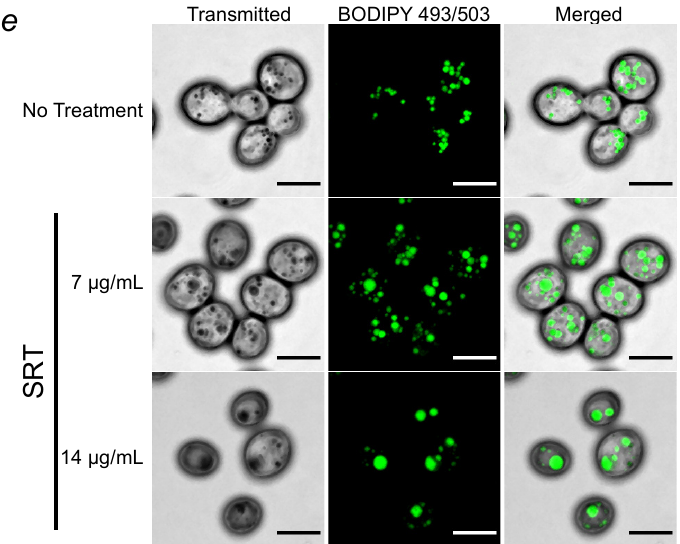
Figure 3. SRT treatment induces SLDs in C. albicans and S. cerevisiae . ( A ) Treatment with SRT induces the formation of enlarged LDs and reduces hyphal growth in C. albicans . SC5314 cells were grown for 12 h in YPD at 30 °C with 150 RPM shaking, then resuspended to a density of 5.0 × 10 6 cells/mL in fresh RPMI-1640 containing the drug. Treated cultures were incubated for 12 h at 37 °C with 150 RPM shaking. Cells were then harvested by centrifugation, fixed with 4% paraformaldehyde, stained with 5 μ M BODIPY 493/503, loaded onto a poly-d-lysine-coated coverslip, and imaged. Images shown are projected from Z-stacks; transmitted images were Z-projected by minimum intensity, while fluorescence images are Z-projected by maximum intensity. Scale bars = 5 μ m. ( B ) Treatment with SRT induces the formation of enlarged LDs in S. cerevisiae . S288c cells were grown for 12 h in RPMI-1640 at 30 °C with 150 RPM shaking, then resuspended to a density of 5.0 × 10 6 cells/mL in fresh RPMI-1640 containing the drug. Cultures were incubated for an additional 12 h at 30 °C with 150 RPM shaking. Cells were then harvested by centrifugation, fixed with 4% paraformaldehyde, stained with 5 μ M BODIPY 493/503, loaded onto a poly-d-lysine-coated coverslip, and imaged. Images shown are projected from Z-stacks; transmitted images were Z-projected by minimum intensity, while fluorescence images are Z-projected by maximum intensity. Scale bars = 5 μ m.